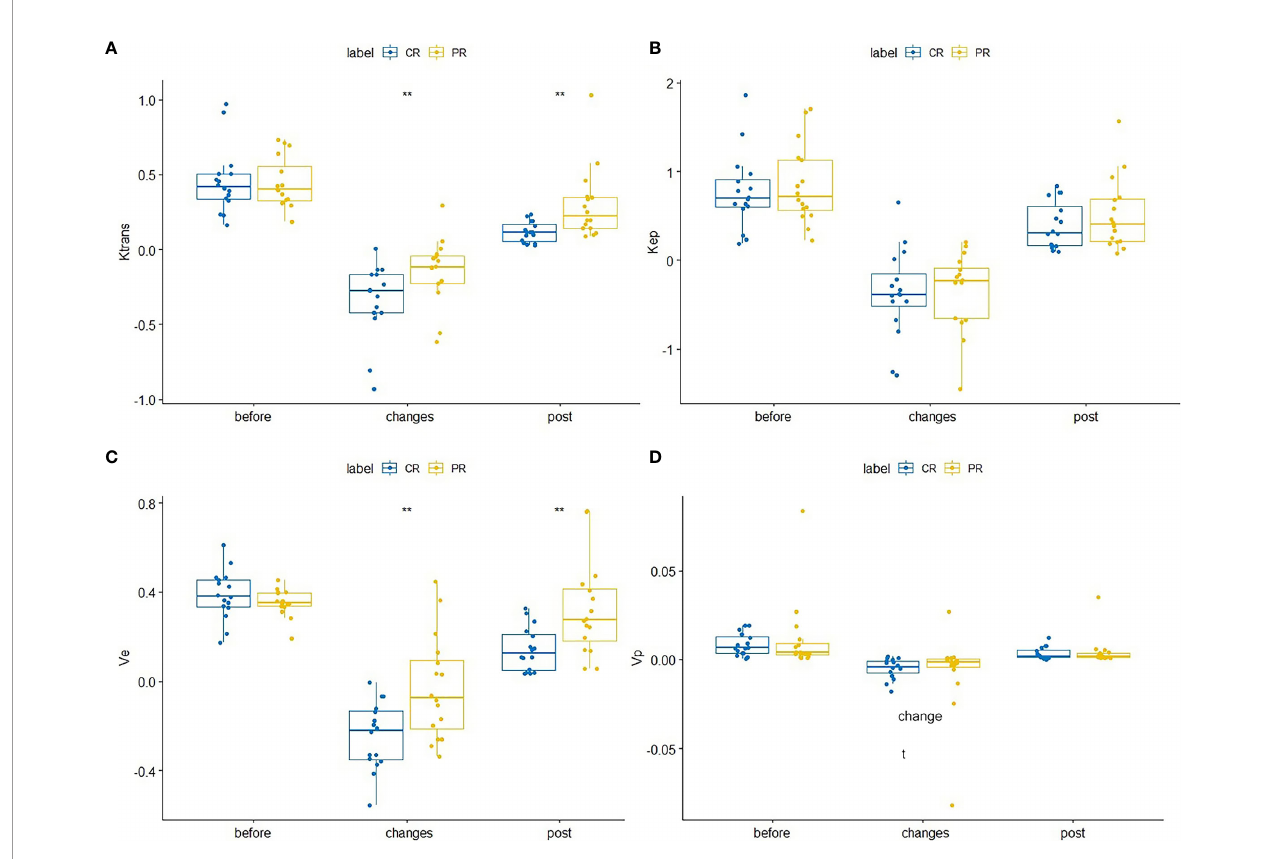
FIGURE 1 | Differences in Ktrans (A) , Kep (B) , ve (C) , and vpV p (D) between the CR and PR groups at the fi rst NACRT, change, and the second NACRT, while the median value of relative vascular permeability parameter levels is displayed as a line within each box. ** means signi fi cant